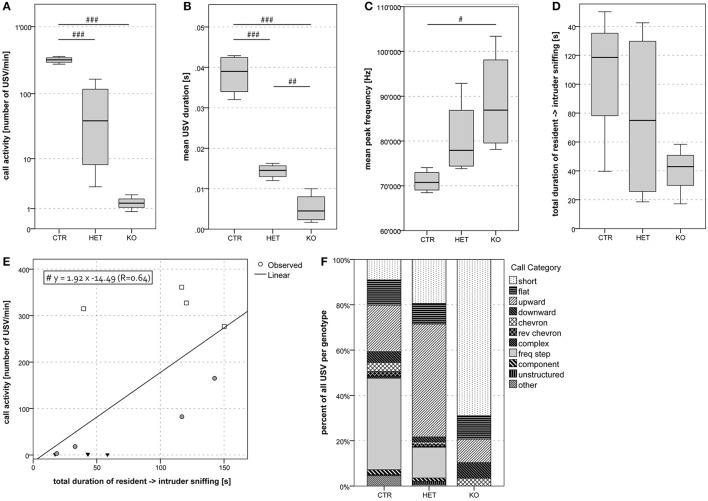
Dyadic interactions between female pairs of mice: lower frequency of vocalization and restricted repertoire in KO-mice. Mean call activity was lower in KO and HET than CTR pairs (A). Mean USV duration was lowest in KO and lower in HET than CTR pairs (B). Mean peak frequency was higher in KO than CTR pairs (C). There was a trend for a higher total duration of resident → intruder sniffing (all body areas) in KO and HET than in CTR pairs (D). In the sample as a whole, we found a positive correlation between mean call activity and the total duration of resident → intruder sniffing (all body areas) (E). Black triangles, circles filled in gray and empty squares represent data of KO, HET and CTR pairs, respectively. KO pairs produced only USV belonging to the less complex types, whereas both HET and CTR pairs produced USV of the entire repertoire (F). (n = 4 CTR, 4 HET, 4 KO). (#p < 0.05, ##p < 0.01, ###p < 0.001).